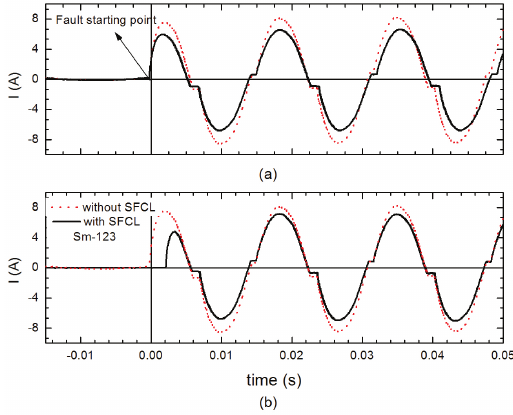
Figure 4. Current of short-circuit of Sm-123 ceramic at 77K. (a) Current limiting characteristics for two superconducting element in series; (b) Only one element in line with the load resistance R